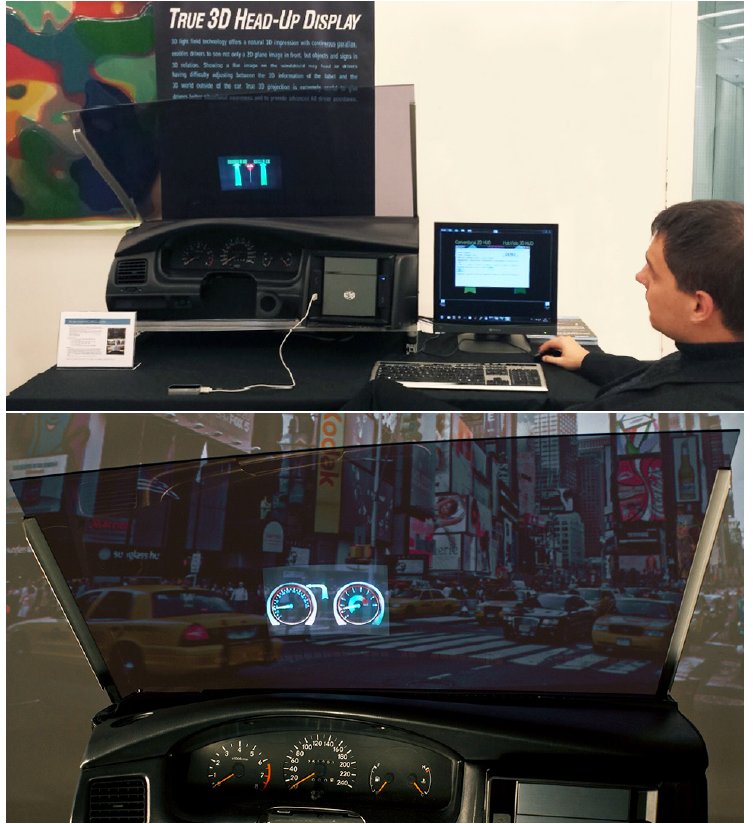
Figure 7. Exhibition of the first automotive light field prototype;